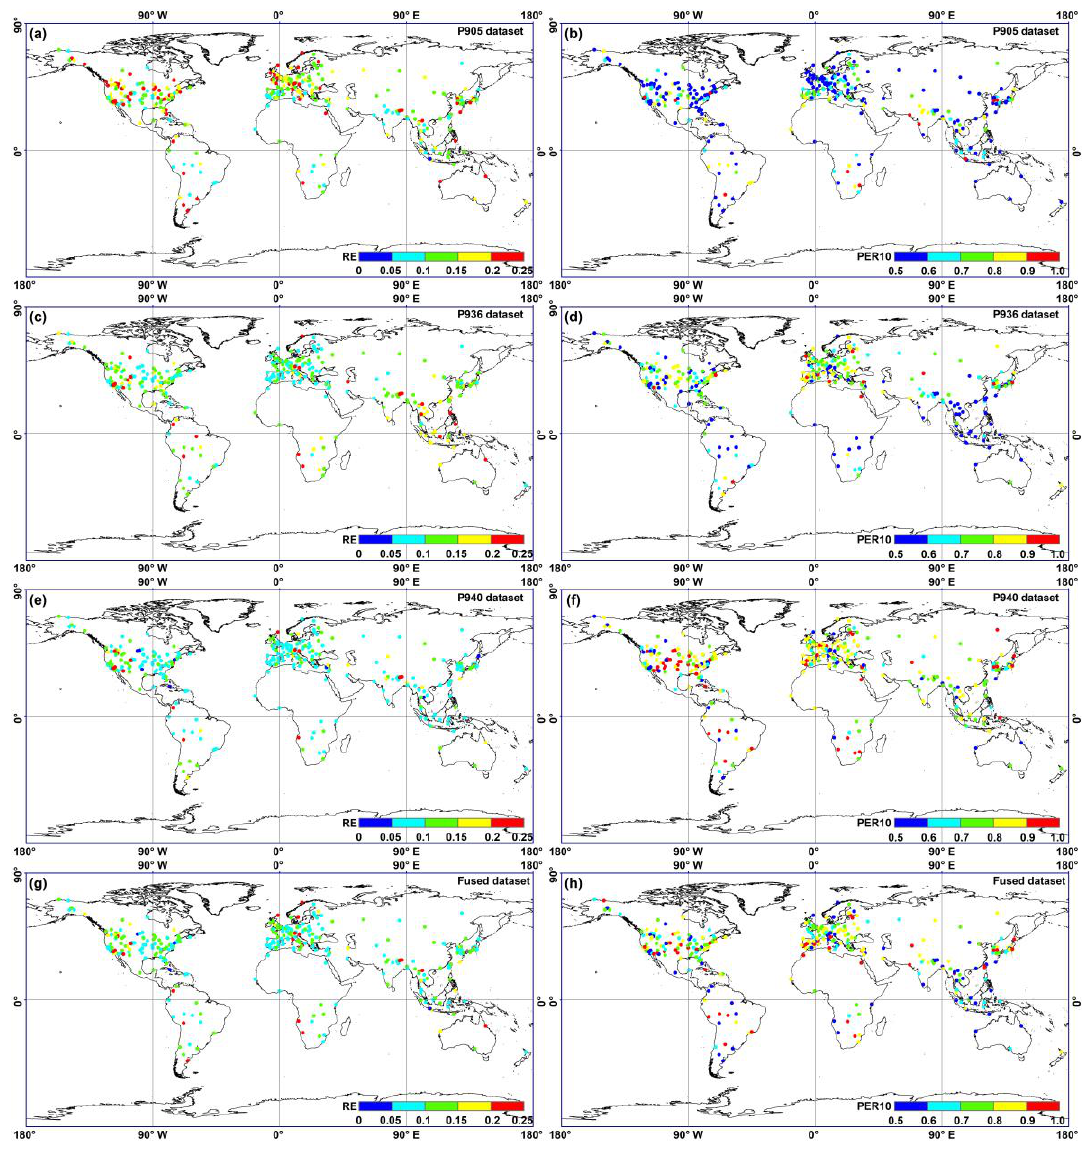
Figure 7. Spatial distribution of RE and PER10 for the four MERSI-2 PWV datasets. ( a ) RE of the P905 dataset; ( b ) PER10 of the P905 dataset; ( c ) RE of the P936 dataset; ( d ) PER10 of the P936 dataset; ( e ) RE of the P940 dataset; ( f ) PER10 of the P940 dataset; ( g ) RE of the fused dataset; ( h ) PER10 of the fused